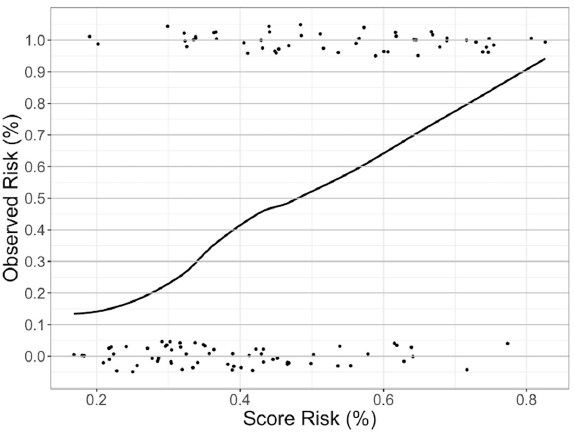
Figure 2 . Probability of incurring CVAEs related to increasing of carfilzomib (CFZ) CVAEs Risk Score. Vertical axis = observed CVAE events (%); Horizontal axis = predicted CFZ CVAE risk (%). The upper points represent patients who experienced CVAEs; the lower points represent patients who did not experienced CVAEs.